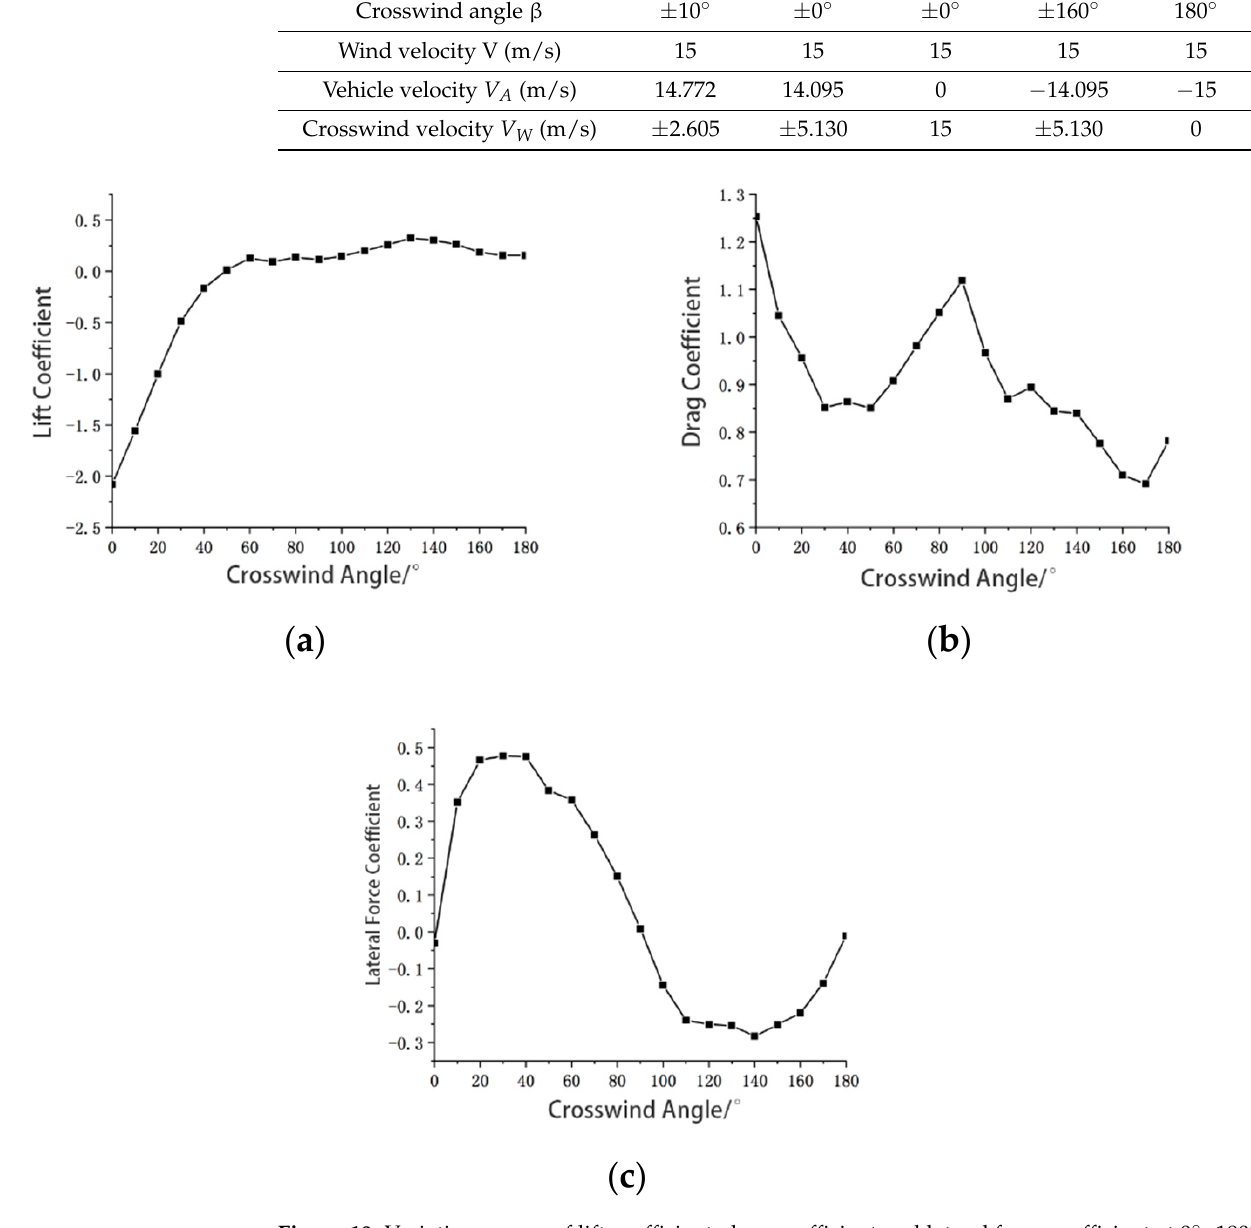
Figure 10. Variation curves of lift coefficient, drag coefficient and lateral force coefficient at 0°~180° crosswind angle: ( a ) lift coefficient, ( b ) drag coefficient and ( c ) lateral force coefficient.